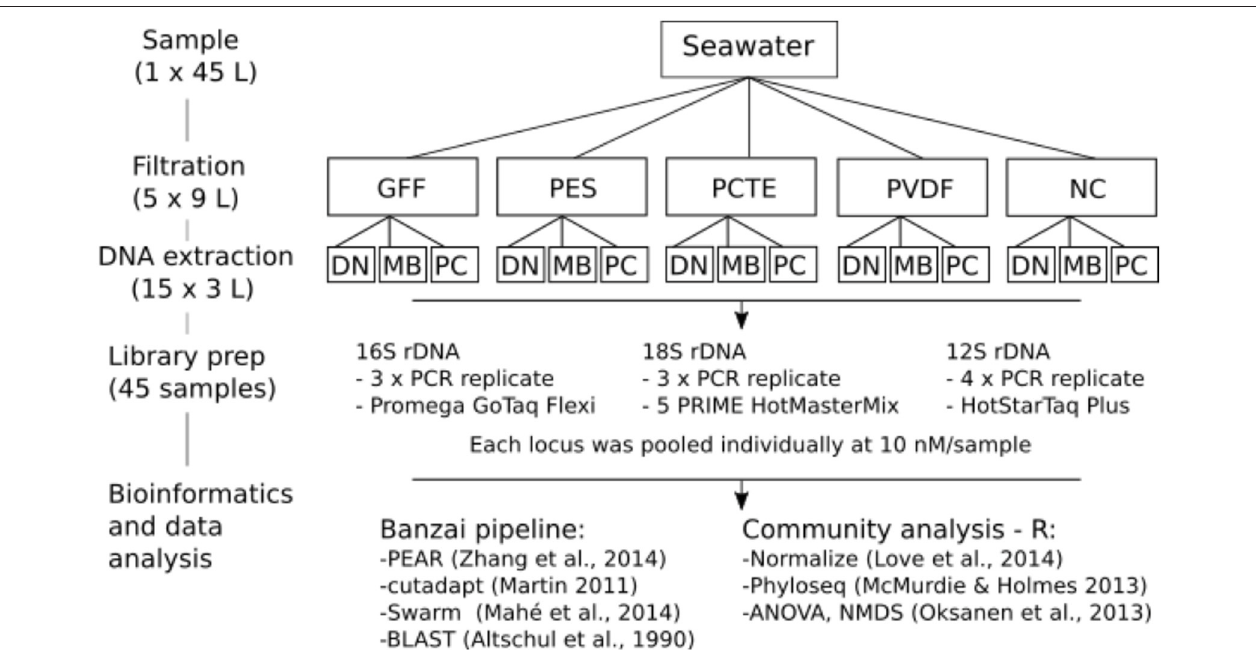
FIGURE 1 | Schematic of sampling and laboratory protocols. Extraction protocols include DN: DNeasy Blood and Tissue Kit (DNeasy), MB: MoBio PowerWater DNA Isolation Kit (MoBio), and phenol/chloroform (PC). Amplification targeted different conserved gene regions for three taxonomic groups—16S rRNA gene: microorganisms, 18S rRNA gene: phytoplankton, and 12S rRNA gene: vertebrates. Community analysis was done in the statistical software